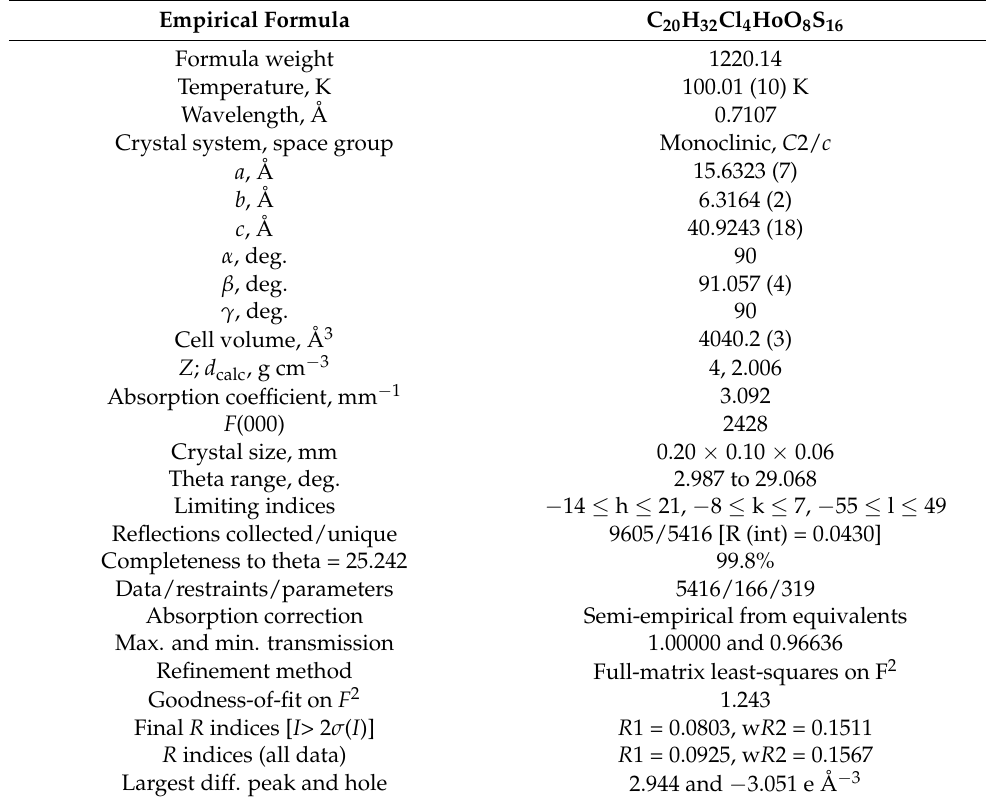
Table 1. Crystal data and structure refinement for 1